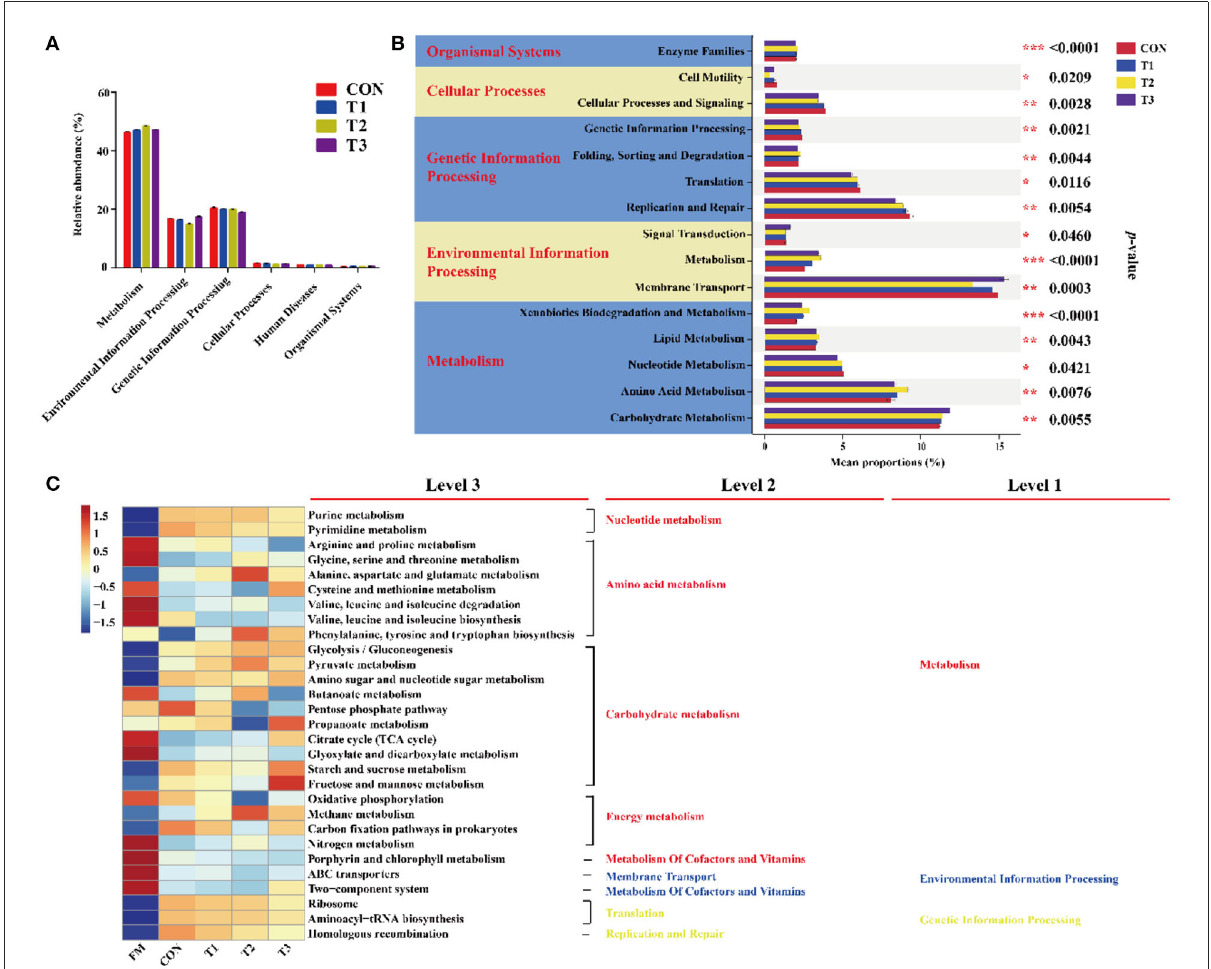
FIGURE3 Dynamics of bacterial functional profiles in different treatments analyzed by PICRUSt ( n = 3). (A) Level 1 metabolic pathway. (B) Level 2 KEGG ortholog functional predictions of the relative abundances with significant differences in the top 20 metabolic functions. (C) Level 3 KEGG ortholog functional predictions of the relative abundances of the top 30 metabolic functions. FM, fresh materials; CON, Samples without inoculants; FM, fresh material; T1, native grass inoculated with Lactobacillus plantarum ; T2, native grass inoculated with Lactobacillus plantarum and Lactobacillus buchneri ; T3, native grass inoculated with Lactobacillus plantarum , Lactobacillus buchneri , and Pediococcus pentosaceus .de. * Indicates significant at p < 0.05, ** indicates significant at p < 0.01 and *** indicates significant at p <